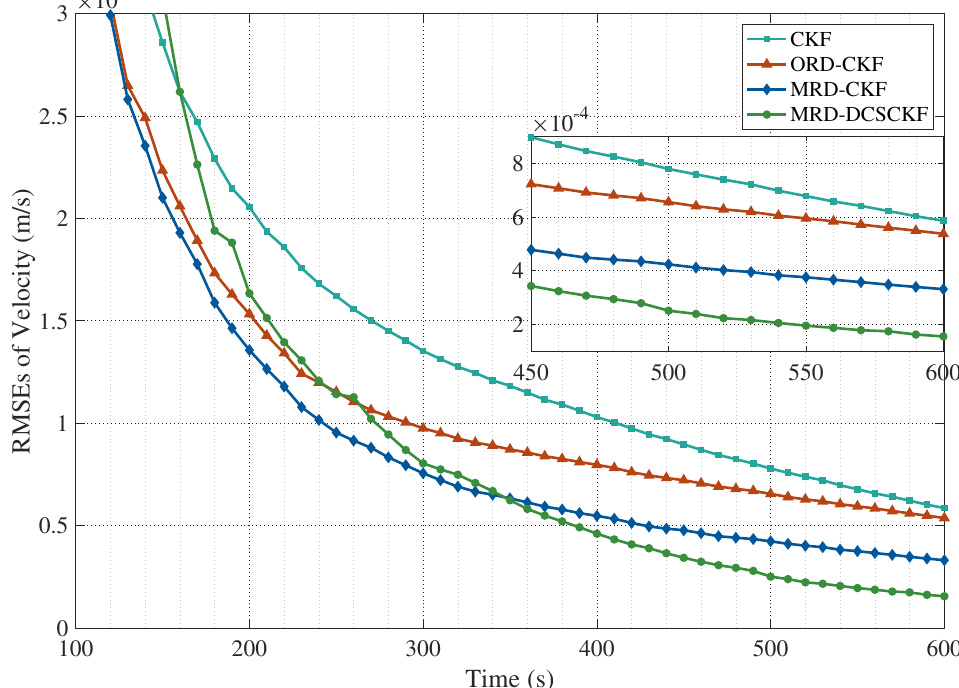
Figure 9. RMSEs of the velocity with CKF, ORD-CKF, MRD-CKF, and